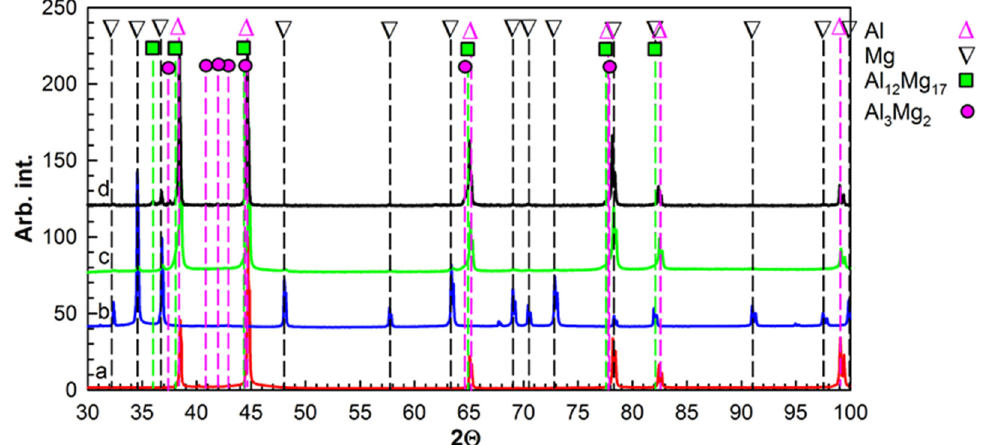
Figure 1. XRD patterns of Al (a), Mg (b) and Al-Mg nanostructured composites under HPT condi- tions (c) and after further annealing at 275 °C